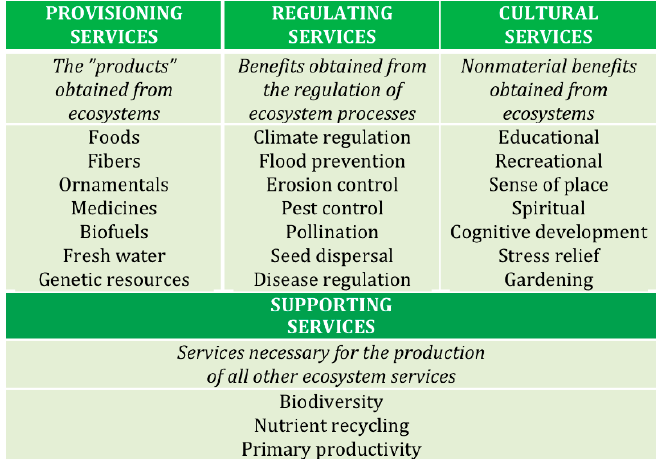
Figure 1. Schematic illustration of a baseline shift of a hypothetical public park over a 150-year period. Each development stage is perceived as being the nondegraded (normal) state by each new generation of humans — a situation that can contribute to environmental generational amnesia.